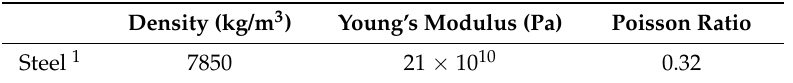
Table 4. The mechanical property parameters of steel material.